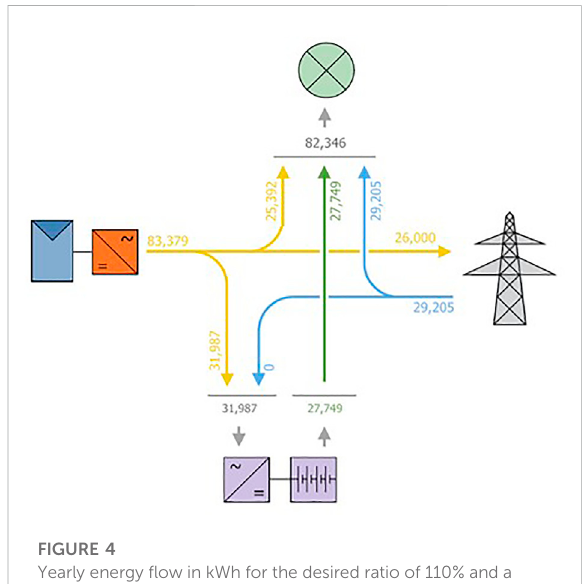
FIGURE 4 Yearly energy fl ow in kWh for the desired ratio of 110% and a year as the reference period.